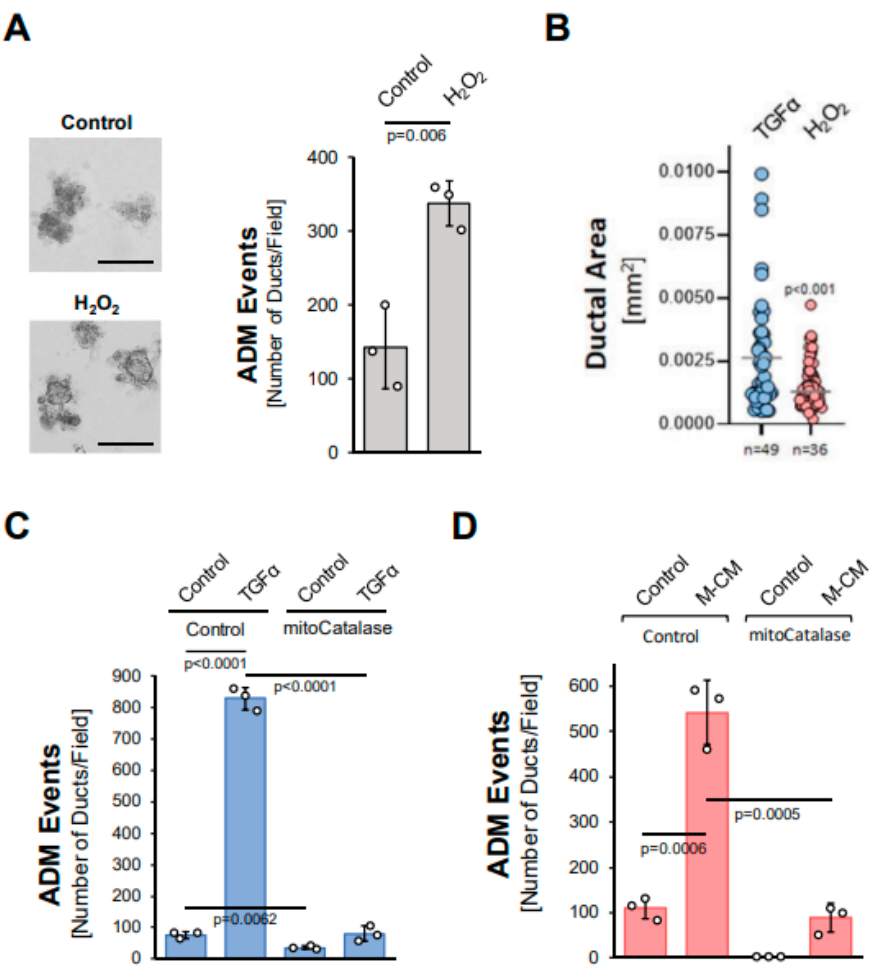
Figure 3. Mitochondria-generated hydrogen peroxide can drive acinar-to-ductal metaplasia. ( A ): Mouse pancreatic acinar cells were isolated, seeded in 3D collagen culture and stimulated with vehicle (Control) or hydrogen peroxide (H 2 O 2 ; 10 µ M). Ducts formed were photographed (left side; bar = 125 µ M) and quantified as indicated in the Methods section. ( B ): Ducts formed after induction of ADM with TGF α (50 ng/mL) or H 2 O 2 (10 µ M) were analyzed for their ductal area using ImageJ. ( C , D ): Mouse pancreatic acinar cells were isolated, infected with rAD-Null or rAD-CVM-mCat and seeded in 3D collagen culture. ADM was induced with 50 ng/mL TGF α ( C ) or M-CM ( D ) and ducts formed were quantified as indicated in the Methods section. ( A – D ): All experiments shown were performed in triplicates for at least three times and obtained similar results in each replicate. Statistical analysis between two groups was performed using the Student’s t -test. A p value of 0.05 was considered statistically significant and values are included in the graphs.